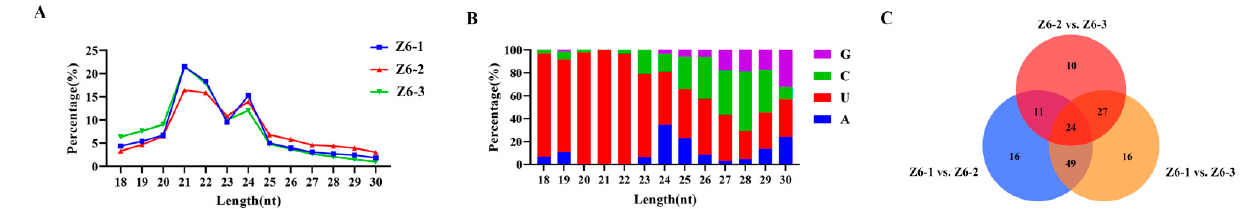
Figure 7. miRNA sequencing analysis of different internodes of lotus. ( A ) Length distribution and percentage analysis of miRNAs from sequencing. ( B ) First nucleotide bias of miRNAs with different lengths. ( C ) Venn diagrams of differentially expressed miRNAs (|log2FC| ≥ 1 and FWER ≤ 0.05) on pairwise comparisons.